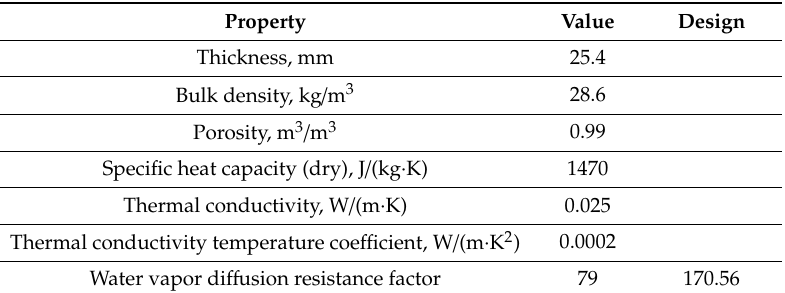
Table A3. XPS property data.